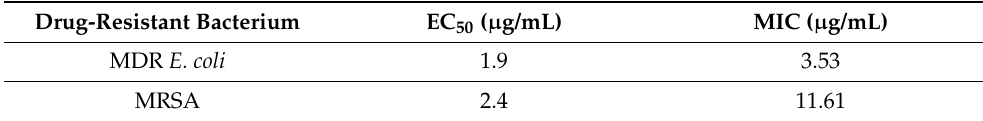
Figure 5. Colony counting assays of ( A ) multidrug-resistant (MDR) E. coli and ( B ) methicillin-resistant Staphylococcus aureus (MRSA) treated with AV-TeNPs; N = 3, where 3 measurements were taken for each biological replicate (denoted as a black bold dot, • ). The magnitude of the mean of the technical and biological replicates and the standard error are shown in the bar chart with error bars. All results showed a p -value < 0.01 versus control. Each mean effect size (denoted as a diamond (cid:7) ) with a 95% confidence interval is indicated by the ends of the vertical error bars plotted on the right axis. Table 3. Half-maximal effective concentration (EC 50 ) and minimum inhibitory concentration (MIC) values for AV-TeNPs against multidrug-resistant (MDR) E. coli and methicillin-resistant Staphylococcus aureus